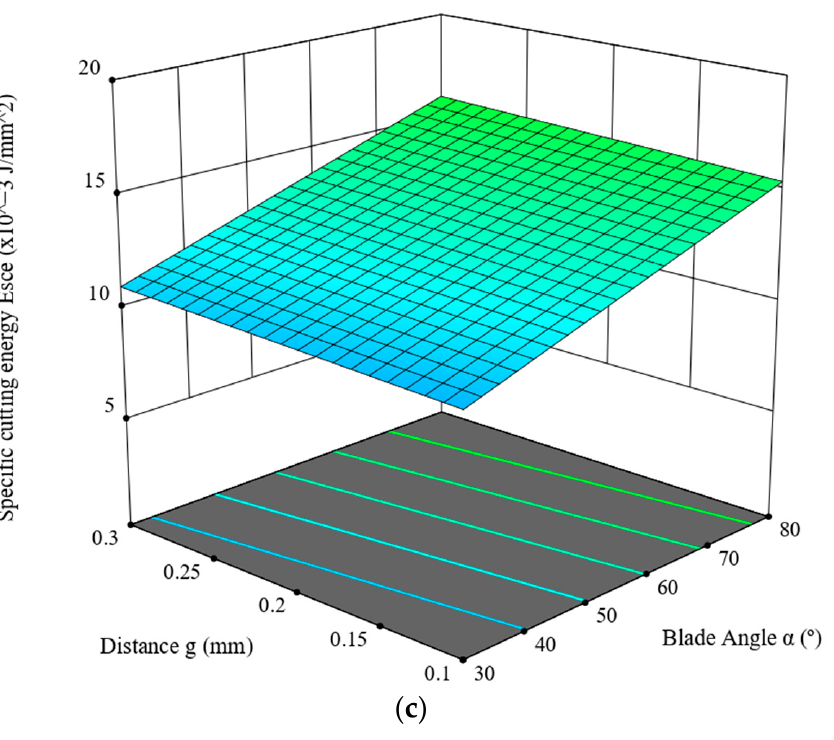
Figure 10. Specific cutting energy, E sce , in the function of the blade angle, α , of the distance, g, for velocity value ( a ) V = 1 mm/s, ( b ) V = 4 mm/s and ( c ) V = 8 mm/s. E sce —total cutting energy (J/mm 2 ), α —knife angle ( ◦ ), g —distance between the blade and the counter blade (mm), V —knife blade velocity (mm/s)